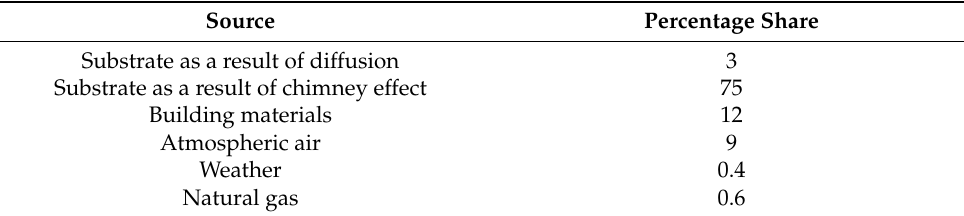
Table 1. Radon source in a typical single-family house, assuming one air change per hour [5]. Source Percentage Share Substrate as a result of diffusion 3 Substrate as a result of chimney effect 75 Building materials Atmospheric